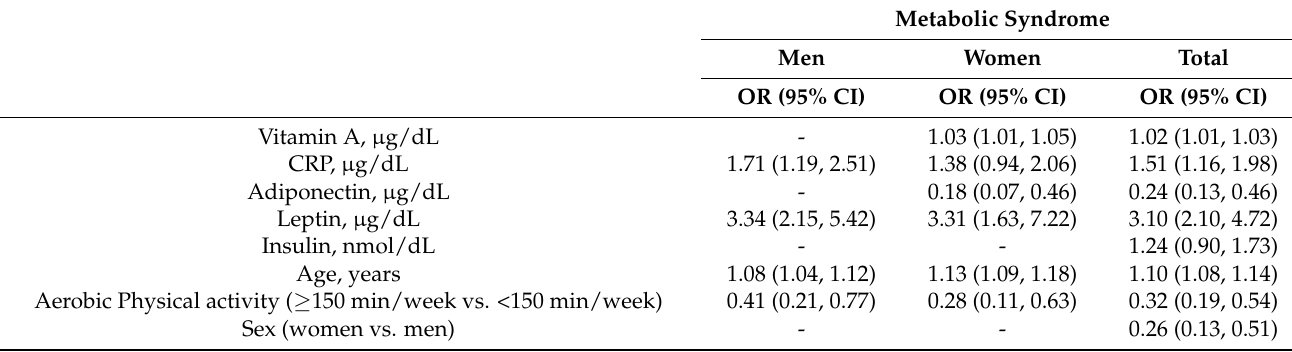
Table 3. Variables selected by the LASSO logistic regression, measuring the association between metabolic syndrome and micronutrients and markers of inflammation and oxidative stress (N = 504).